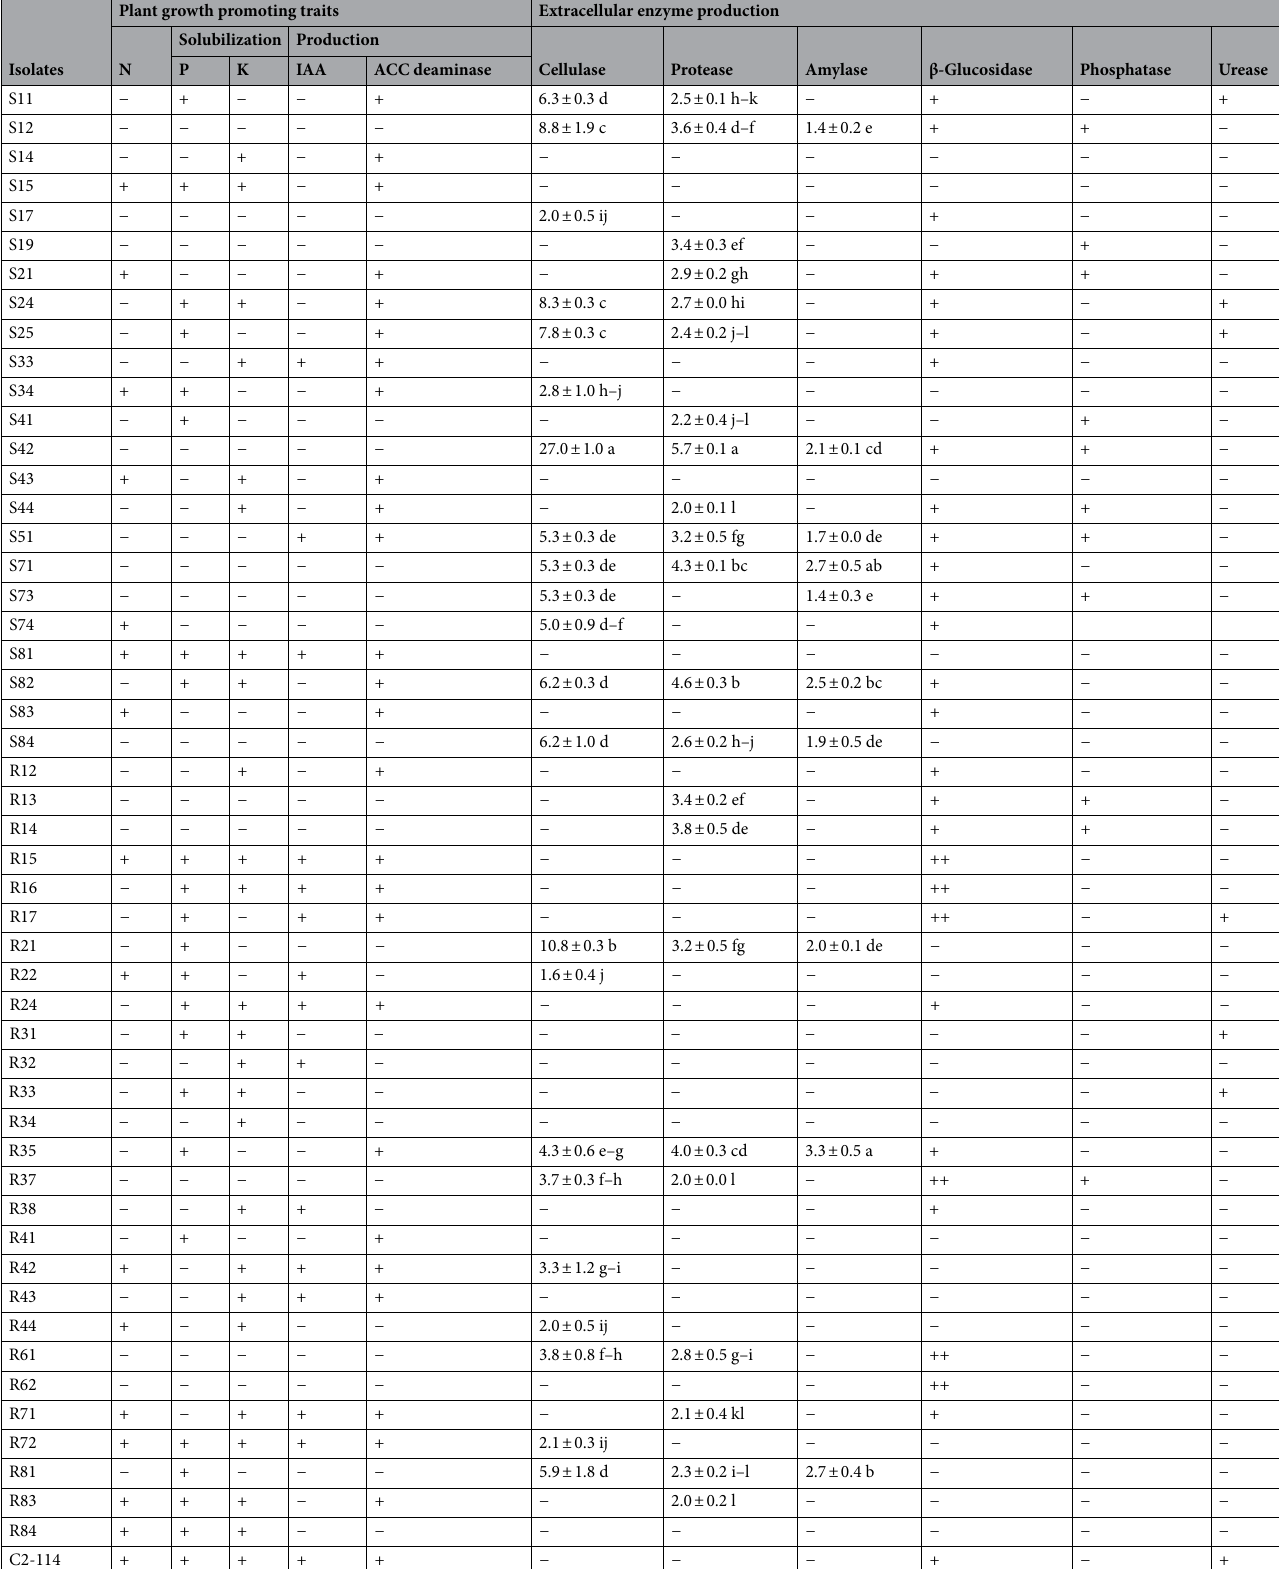
Table 1. Characteristics of PGP and hydrolase traits exhibited by rhizobacterial isolates. N nitrogen fixation, P phosphate, K potassium, IAA indole-3-acetic acid, ACC 1-aminocyclopropane-1-carboxylic acid, − negative result, + positive result; Production of β - glucosidase: + halo below 1 cm, ++ halo greater 1 cm; Production of cellulase, protease, and amylase presented as relative index value with standard deviation. Different letters represent significant differences ( p < 0.05) according to the LSD